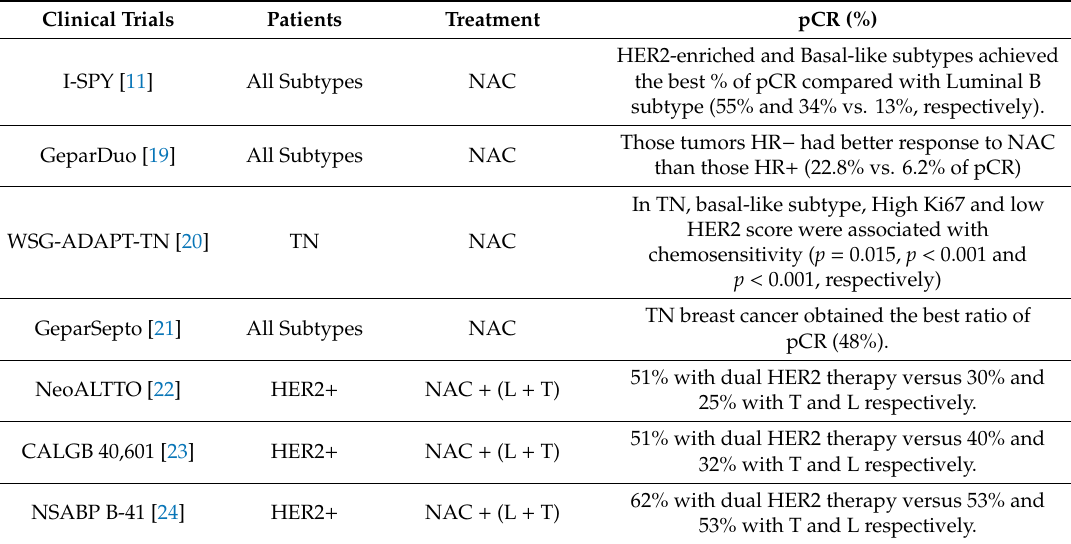
Table 1. Summary of clinical trials based on